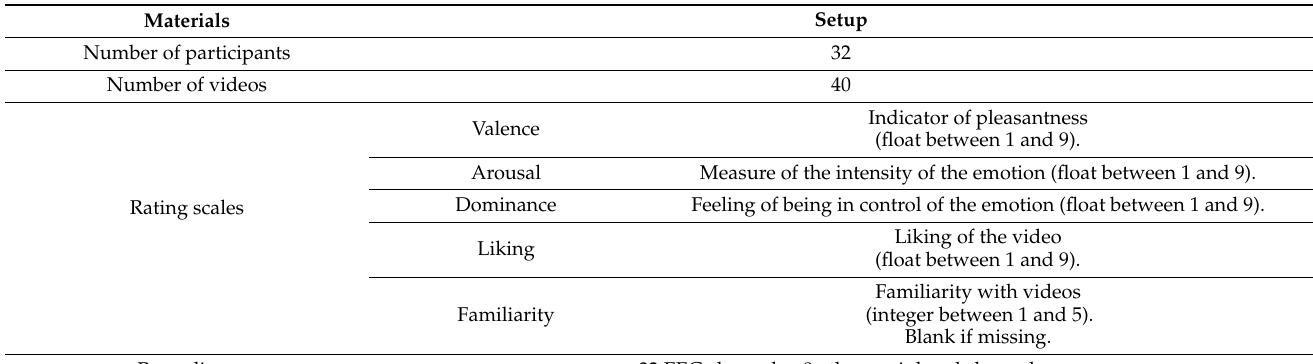
Table 1. Description of participant ratings part in DEAP dataset.